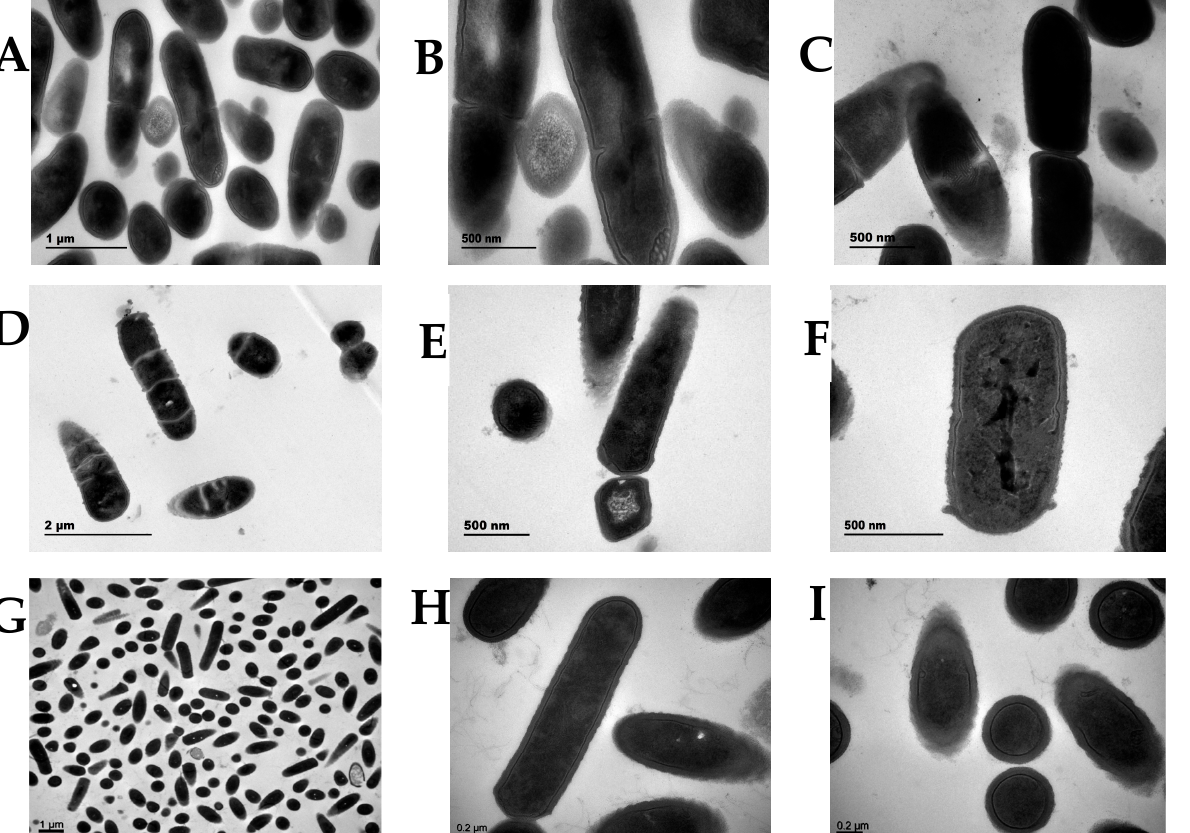
( A – C ) Transmission electron microscopy of strain LA. ( D – F ) The galU gene knockout strain, ∆ galU .